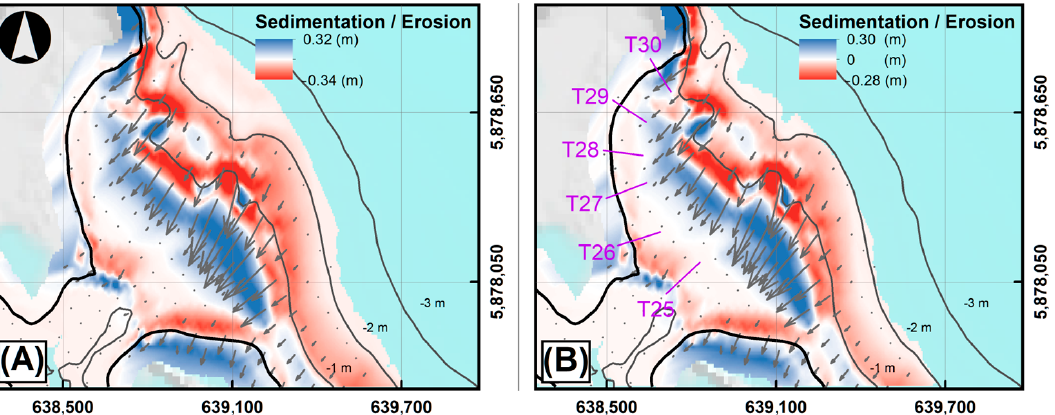
Figure 16. Morphological changes in Tubul during: ( A ) winter and ( B ) summer, as in Figure 13. T25–T30 are control transects at Tubul beach.